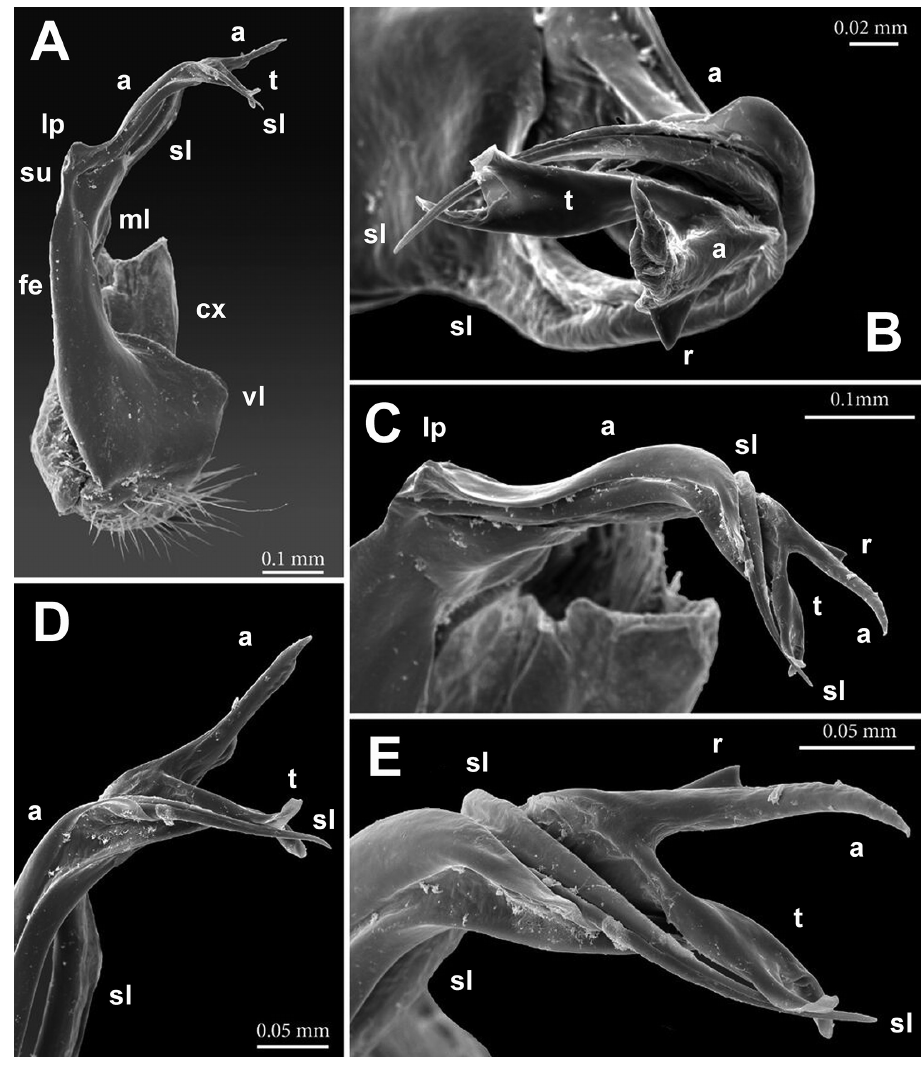
Figure 7. Annamina attemsi sp. n., ♂ paratype (NHMW), SEM micrographs. A entire right gonopod, ventral view B–E distal part of same gonopod B oral C subventral D ventral and E subventral views, respectively (cx = coxite; fe = femorite, vl = ventral lobe; ml = mesal lobe; r = subapical ridge; su = postfemoral sulcus; lp = lateral process; a = apical process; sl = solenomere; t = solenophore tooth). Annamina irinae sp. n. http://zoobank.org/44D470B6-EB4D-473F-8B15-E7626B4CB9F7